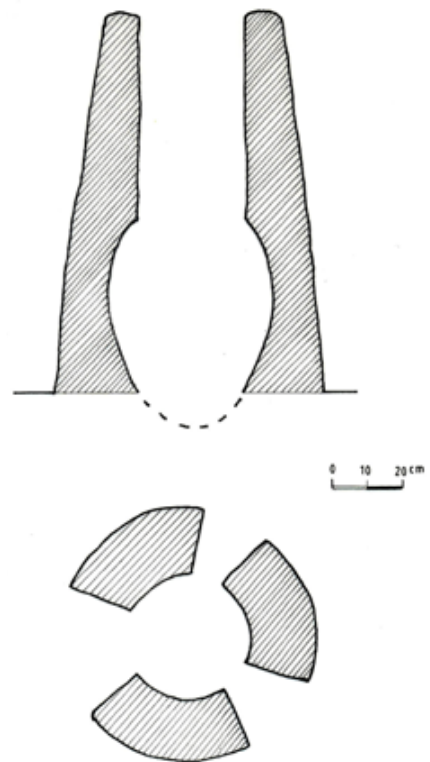
Fig 6: The section and plan of the Nundu SE2 intact